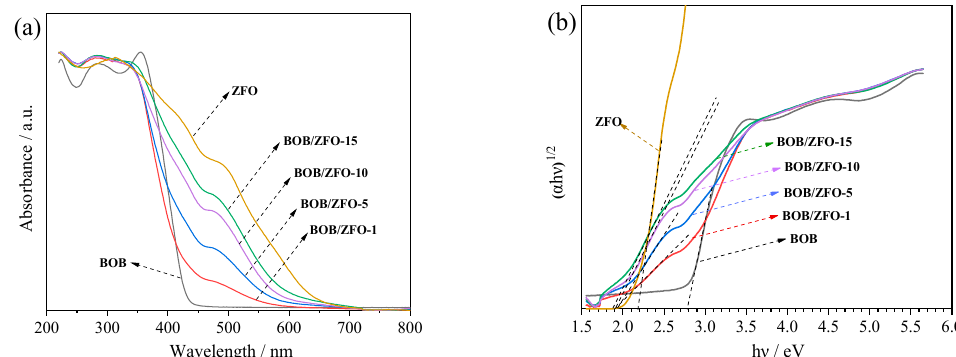
Figure 7. ( a ) UV-vis DRS spectra of the synthesized samples; ( b ) plots of (F(R ∞ ) h υ ) 1/2 vs. h υ for the bandgap energies of the photocatalysts.